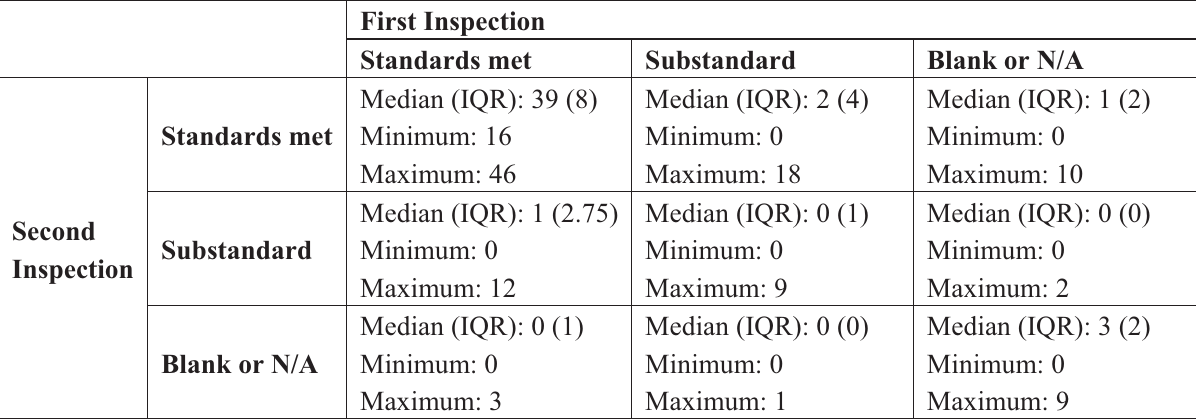
Table 2. The number of criteria per zoo for each of nine possible outcomes at the first and second inspections: n = 136